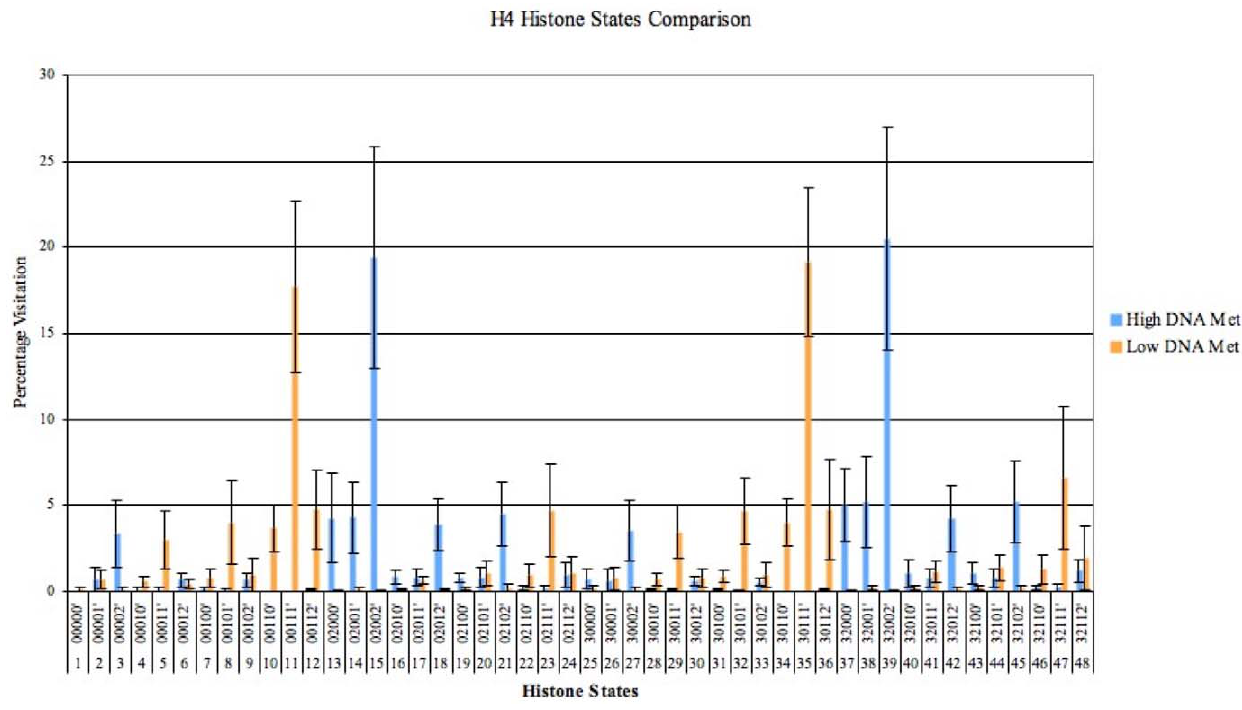
Figure 9. A Comparison between the average (of all 20 test results obtained for H4-1 and H4-2) preferences of H4 states for high and low DNA Methylation Levels. Error bars represent the standard deviation calculated from the total number of visits, for every H4 histone state (occupancy) during the simulation.